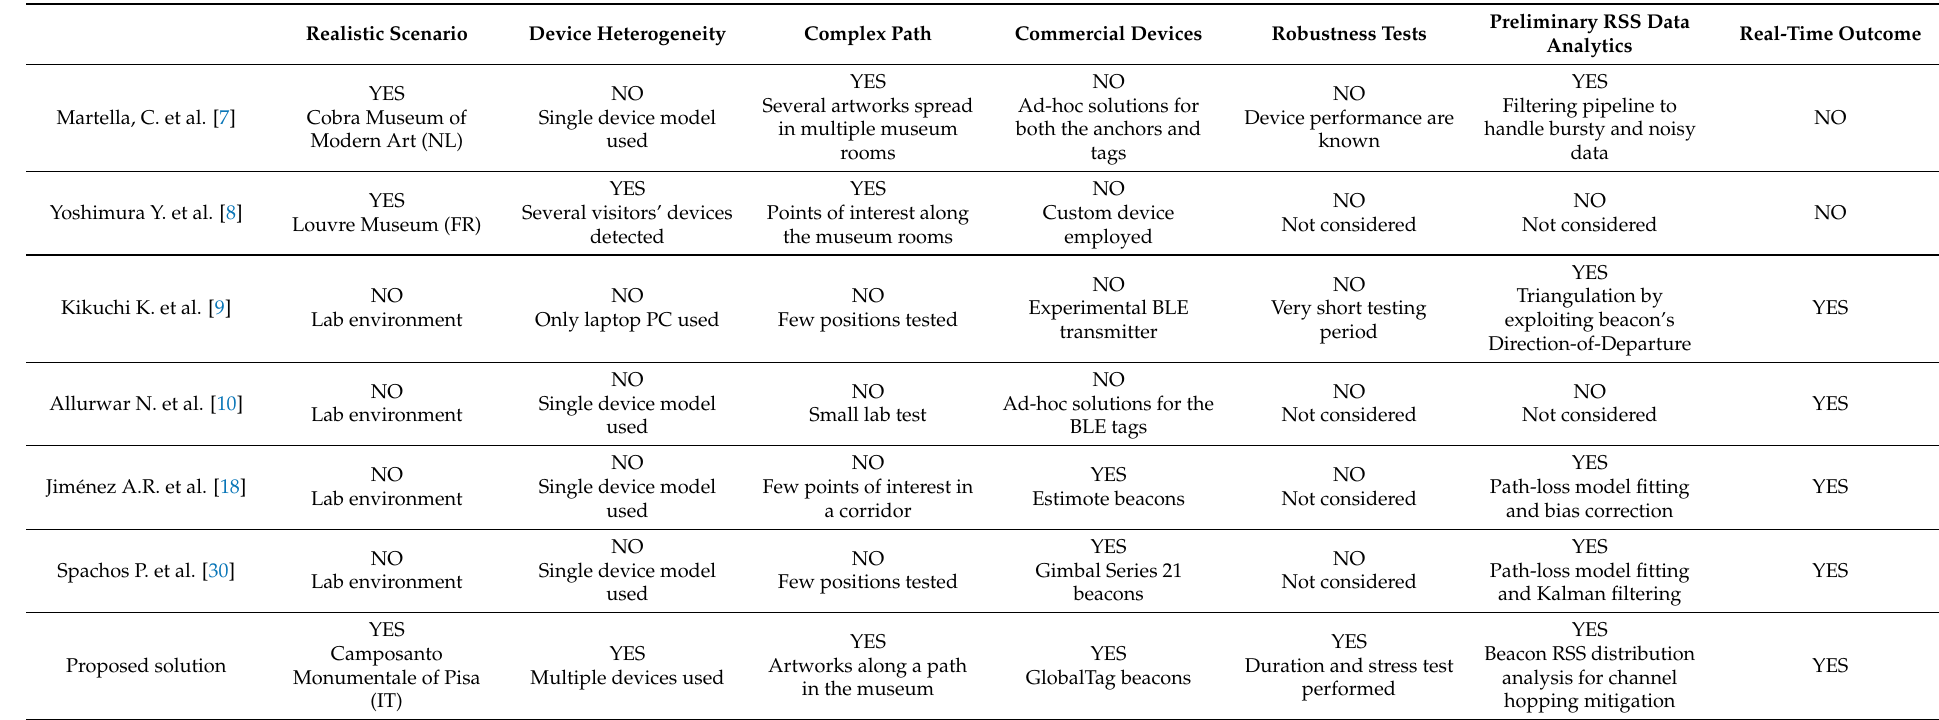
Table 2. Comparison of selected BLE proximity detection solutions for indoor